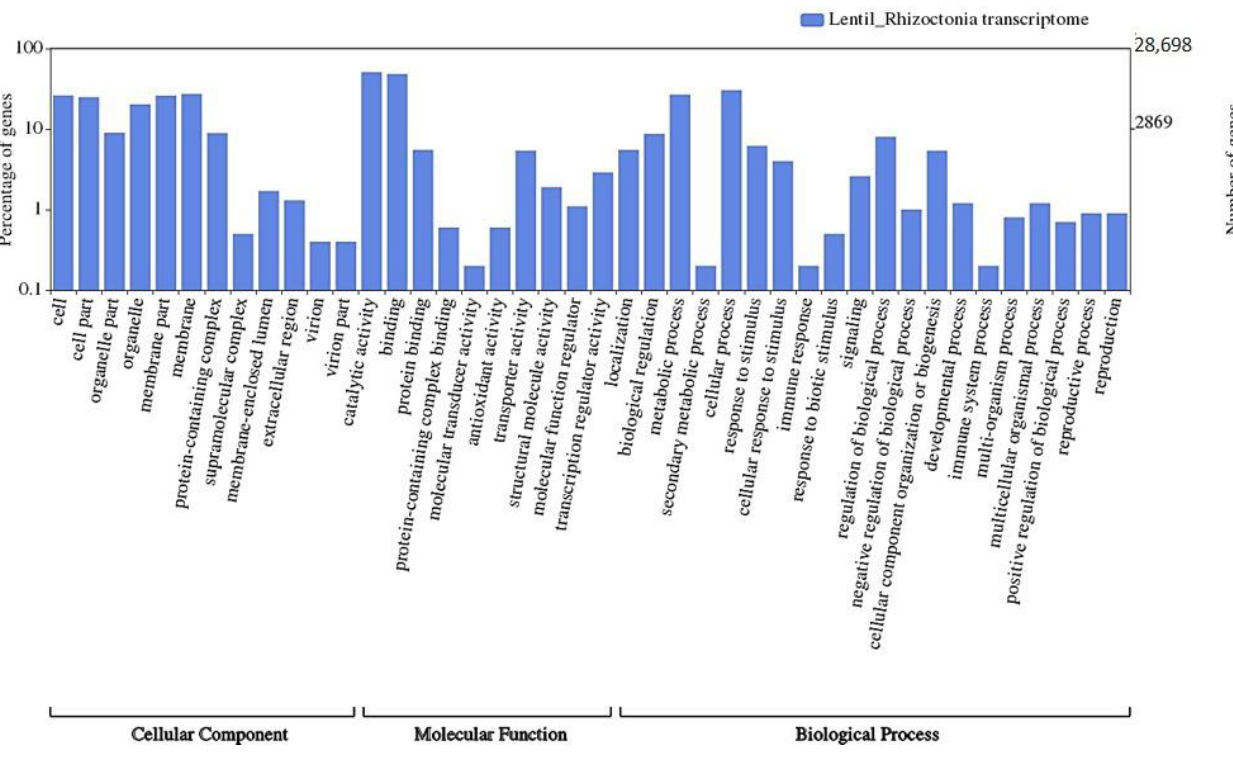
Figure 2. Functional annotation of unigenes that are based on GO categorization of lentil and Rhizoctonia transcriptome. These GO terms are classified into three categories (cellular component, molecular function, and biological processes).